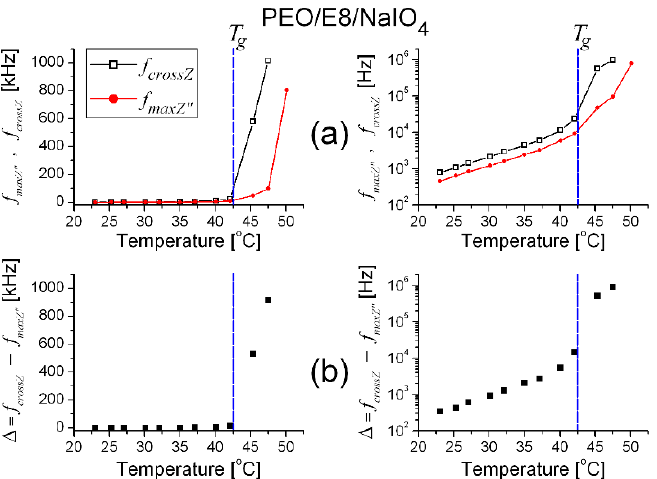
Figure 4. The frequencies f cross and f maxZ″ ( a ), as well as the difference Δ = f cross − f maxZ″ ( b ) vs. the temperature for PEO/E8/NaIO 4 composite, in linear ( left ) and logarithmic ( right ) scale. The dashed lines point out the glass transition ( T g ) and melting temperature ( T m ) values of the PEO/E8/NaIO 4 composite. The uncertainty limits for the experimental data presented are within the size of the symbols for the data.